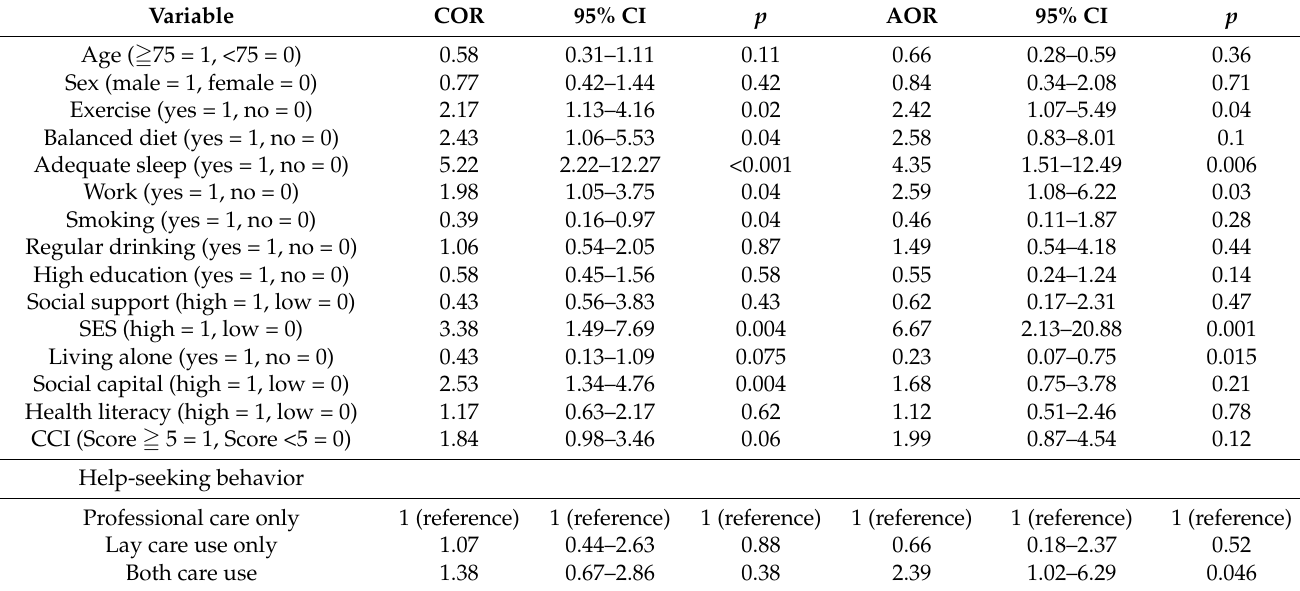
Table 2. The relationship between self-rated health and other demographic